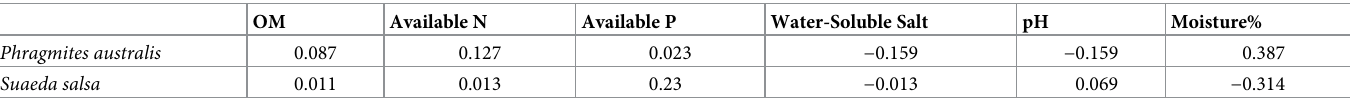
Table 3. Correlation coefficients of two plant species and soil properties in the Yellow River Delta Nature Reserve wetlands. OM Available N Available P Water-Soluble Salt pH